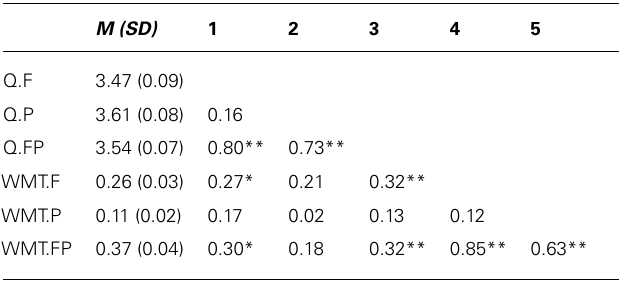
Table 5 | Means ( M ), standard deviations ( SD ), and correlations betweenTFMWQ-C andWMT.